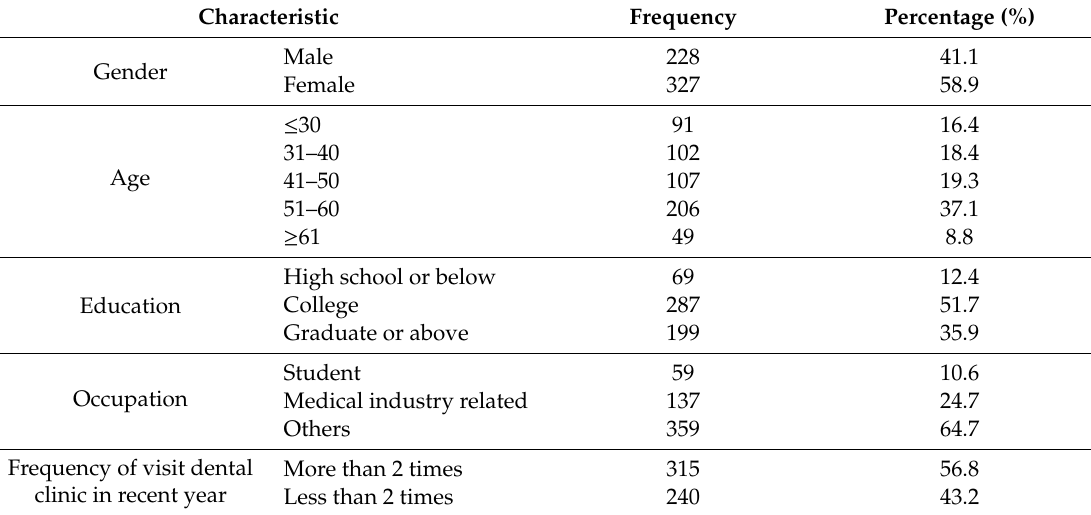
Table 2. Demographic characteristics of respondents ( N =